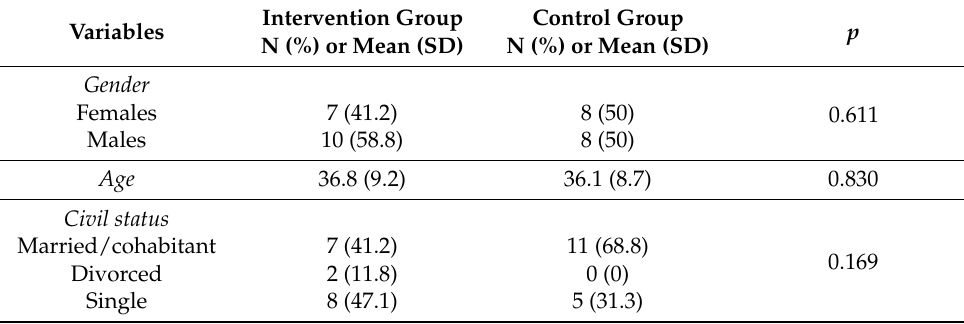
Table 1. Characteristics of the two groups of participants to the